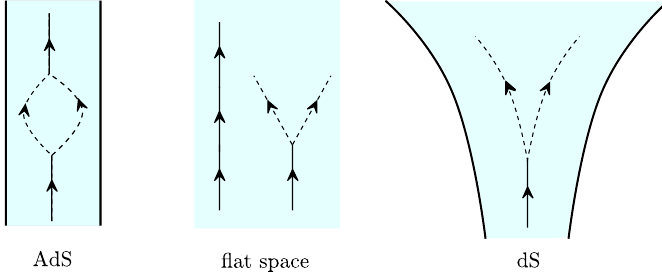
Figure 12 . Decay of a particle in AdS, flat-space and dS. In AdS, the gravitational potential bounces back everything and particles can never be unstable. In flat space, most of heavy particles can decay while some particles (bound states below the threshold) can remain stable. In dS, particles are more likely to decay because of the expansion of the